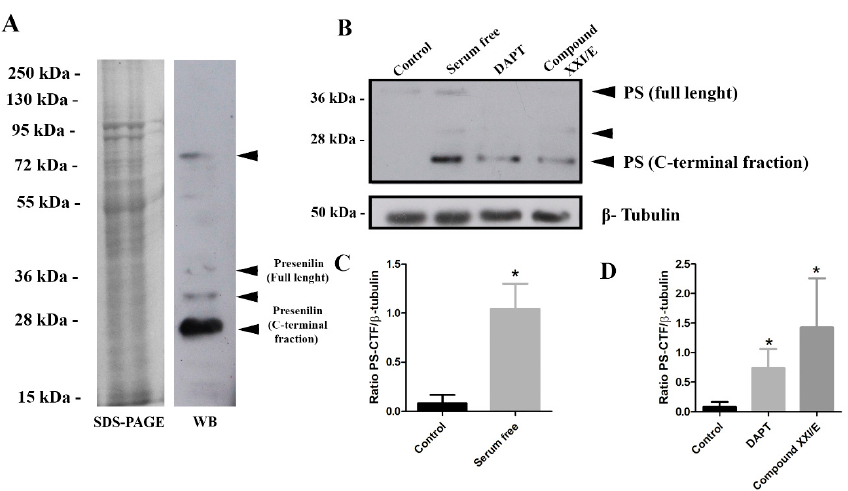
Figure 4. Performance of the anti-EP8 rabbit polyclonal serum for detection of the T. cruzi PS-like protein. ( A ) SDS-PAGE of CL strain epimastigote whole extract (20 µ g) and a corresponding Western blot probed with anti-EP8 serum. Four main bands were identified (arrows). ( B ) Western blot of whole-cell extracts (20 μ g) from epimastigotes under serum deprivation conditions and after treatment with gamma-secretase inhibitors, DAPT (100 μ M) and Compound XXI/E (200 μ M) after 24 h with polyclonal anti-EP8 serum or anti- β -tubulin antibodies (internal control). Densitometry analysis of the Western blots presented as the ratio of T. cruzi PS-CTF and β -tubulin under nutritional stress ( C ) and treated with DAPT (100 μ M) or compound XXI/E (200 μ M) ( D ). Data represent the mean and standard deviation from at least three independent experiments. * Significant difference using t -test ( p < 0.05).